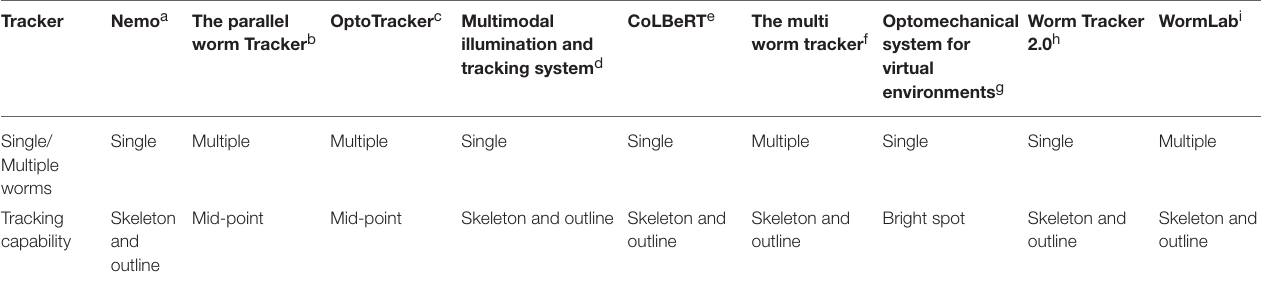
TABLE 1 | Summary of C. elegans tracking software features. Tracker Nemo a The